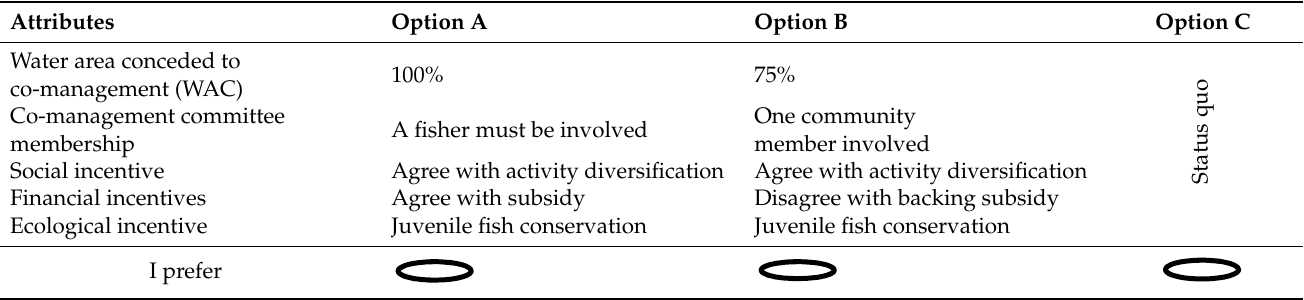
Table 2. Example of choice card.